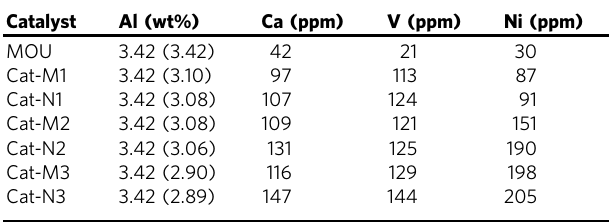
Table 5 Contents of several typical metal impurities in fresh and used catalysts with different reaction cycles under methane and